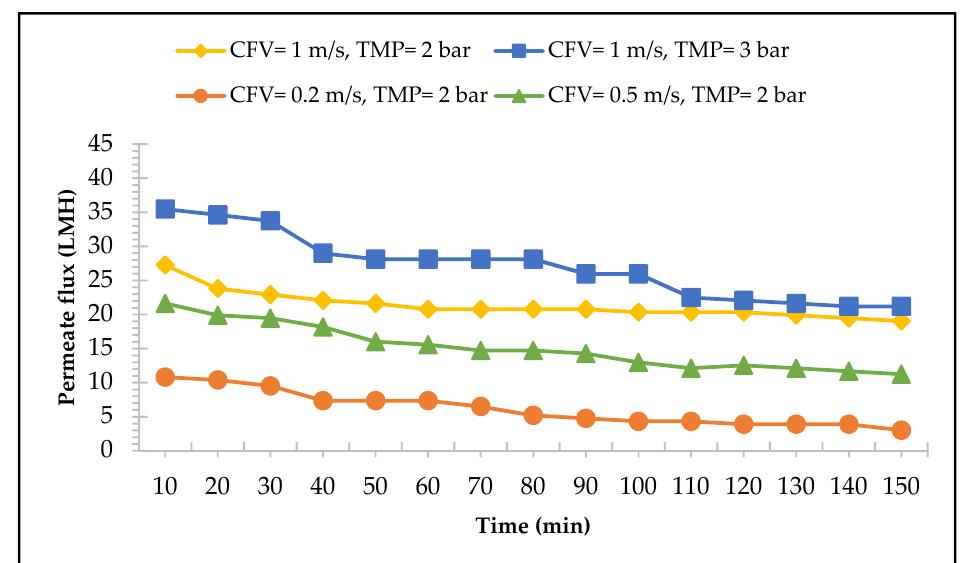
Figure 4. The permeate fl ux of UF membrane with the function of time in di ff erent CFVs and TMPs .